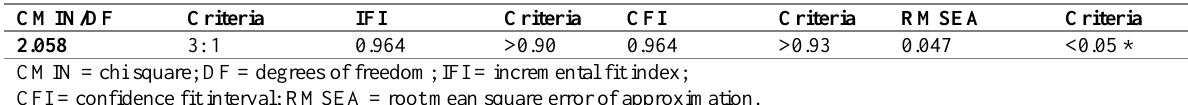
Table 3: Model Fit Indices for The Structural Model